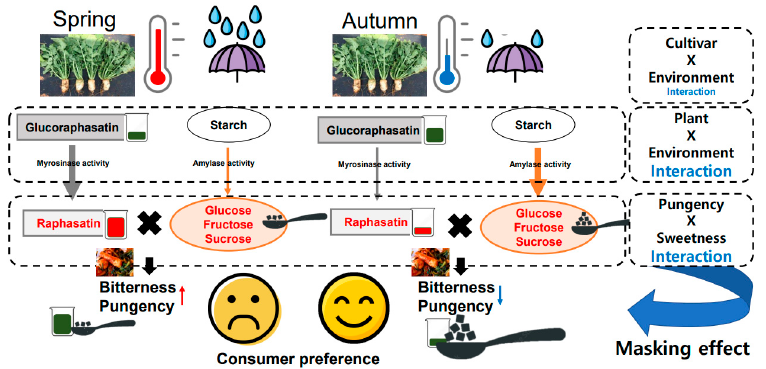
Figure 8. Proposed mechanism of bitterness change of Altari radish by seasonal effect. Significantly lower growing temperature and rainfall before harvest affect glucoraphasatin biosynthesis and myrosinase-mediated conversion and starch-sucrose metabolism. These enzymes and metabolites change by seasonal effect and change the ratio between bitterness/pungency and sweetness. Autumn Altari radish root is less bitter and pungent to consumers due to the masking effect from sweetness of sugars.